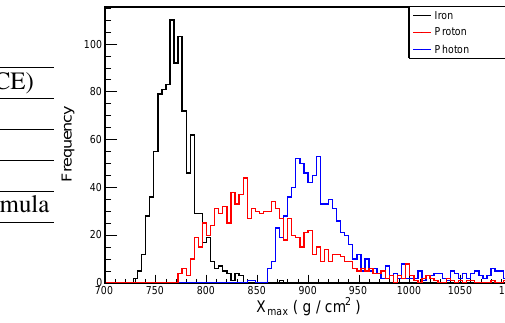
Figure 3. The X max distribution for primary proton, photon and iron (primary energy10 20